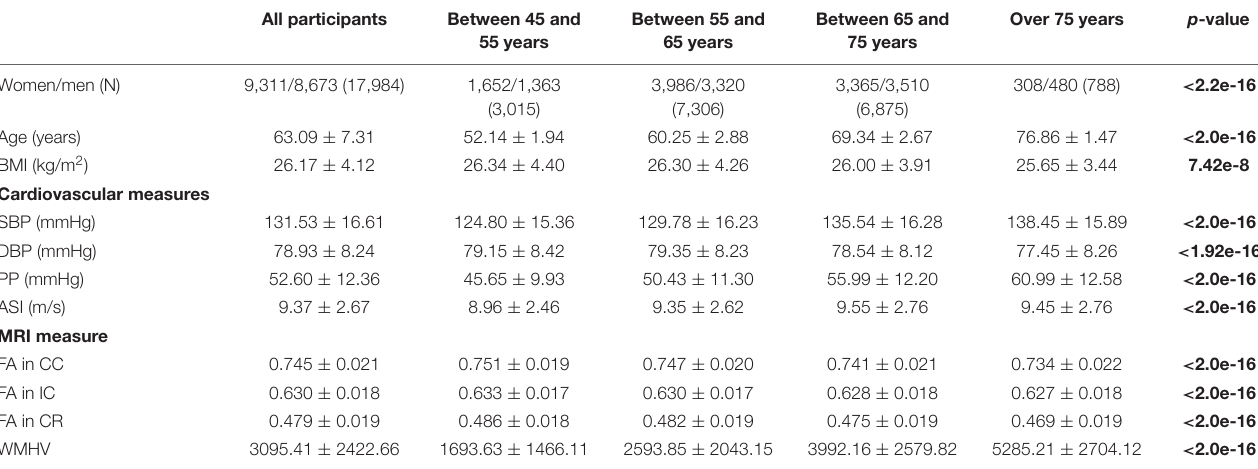
TABLE 1 | Characteristics of all